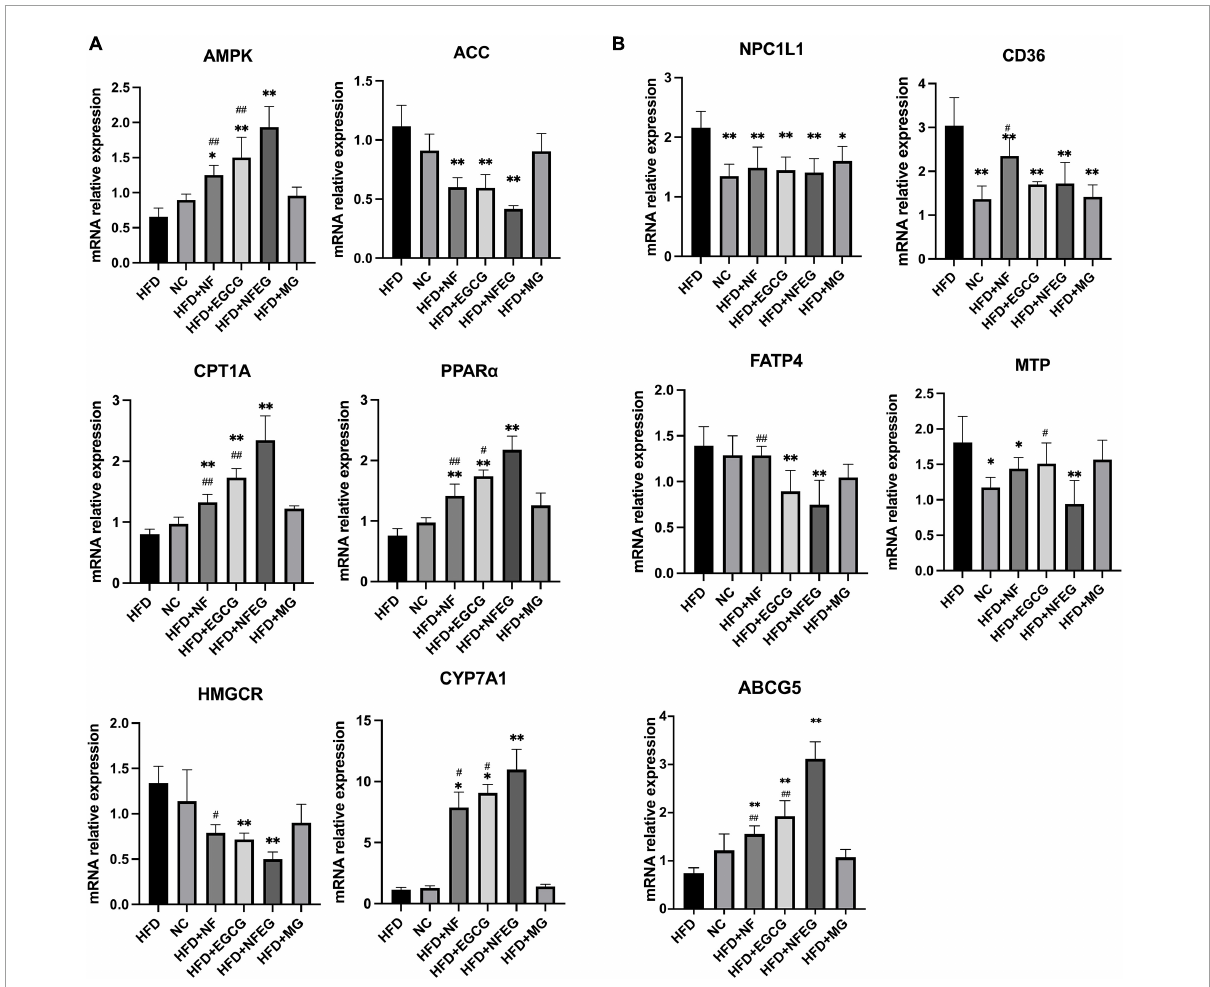
FIGURE3 mRNA levels in rat liver and small intestine: (A) expression of AMPK, ACC, CPT1A, PPAR α , HMGCR, and CYP7A1 in rat liver; and (B) expression of NPC1L1, CD36, FATP4, MTP, and ABCG5 in rat small intestine. (* P < 0.05) and (** P < 0.01) vs. HFD group; ( # P < 0.05) and ( ## P < 0.01) vs. HFD + NFEG